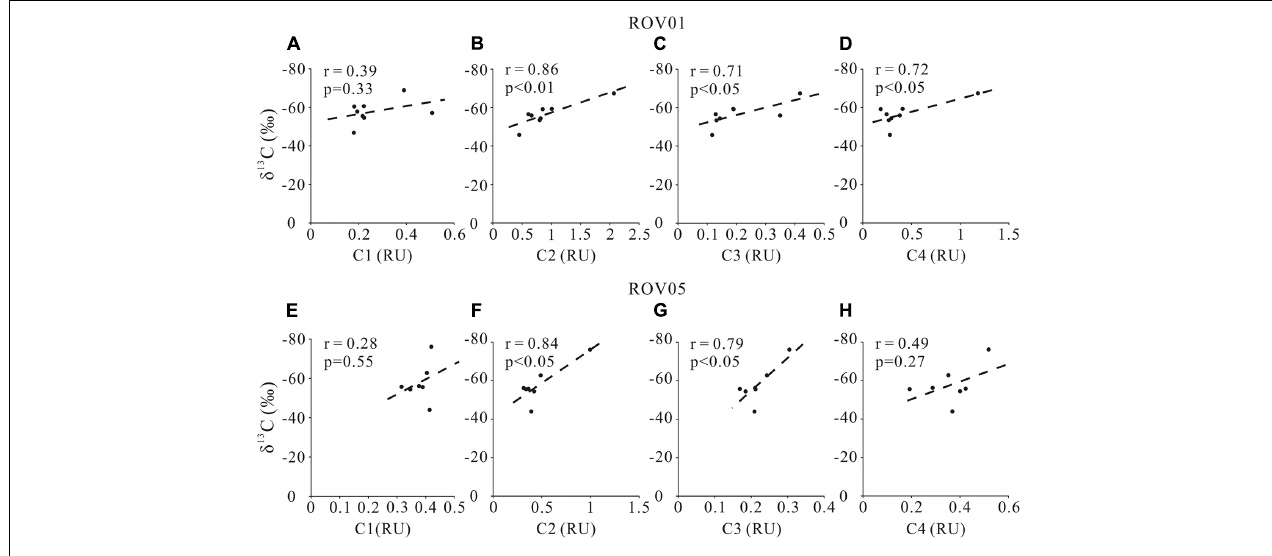
FIGURE 8 | Cross-plots δ 13 C-DOC and FDOM components (C1, C2, C3, and C4) for the seeps sites ROV1 (A–D) and ROV5 (E–H) .